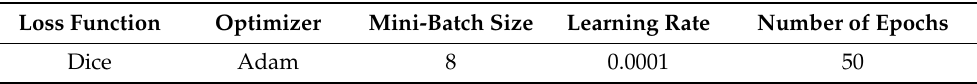
Table 4. Parameters for training of suggest and enhancement